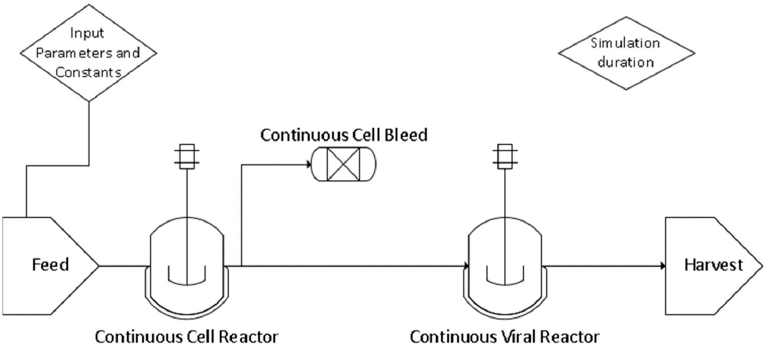
Figure 6. Continuous flowsheet model: The figure above shows the flowsheet model developed for the continuous platform presented in this paper. The flowsheet was developed in gPROMS.